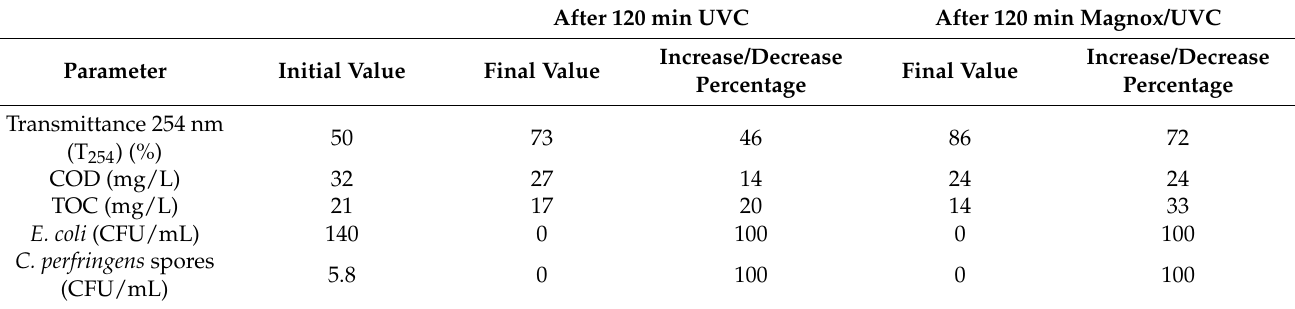
Table 1. UVC and Magnox/UVC tertiary treatment